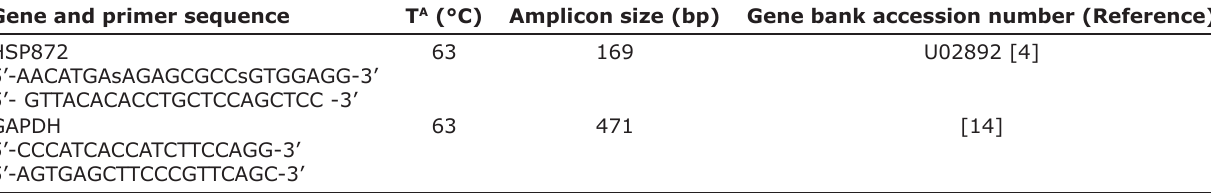
Table-1: Details of HSP72 and GAPDH genes. Gene and primer